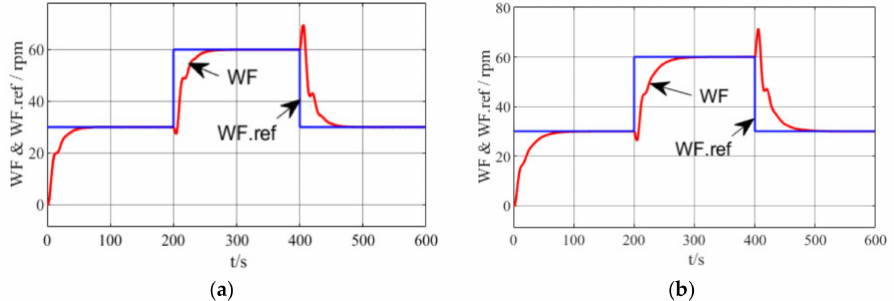
Figure 20. While β alter, the generator speed waveform of PID control based on IMC and experiment scheme 2. ( a ) The speed waveform of β = 15, ( b ) The speed waveform of β = 20.